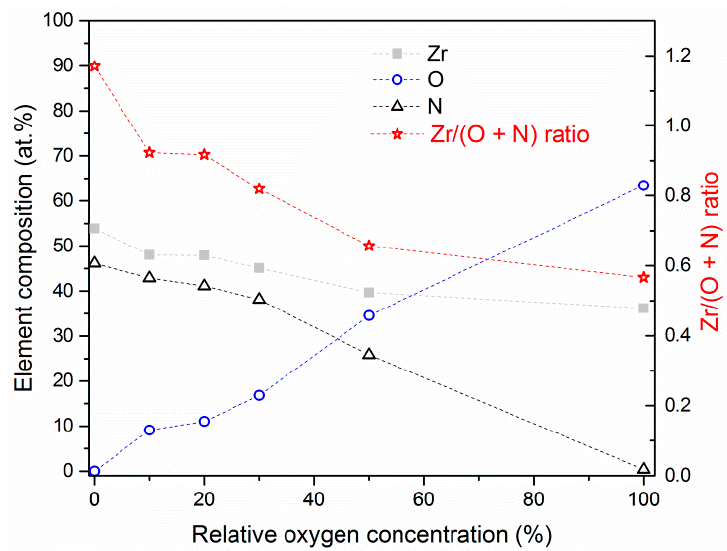
Figure 6. Chemical composition of ZrON coatings formed at various relative oxygen concentrations. Dashed lines are placed only for eyes guiding.